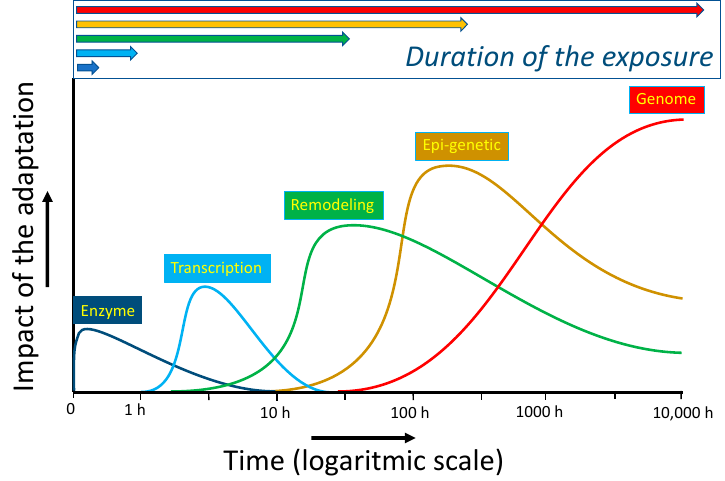
Figure 7. The difference in impact and in the time of onset and duration of several types of adaptations of a cell based on the molecular mechanism of the adaptation. Direct modification of the activity of an enzyme by exposure is an acute adaptive response of cells. In adaptation, due to the activation of the transcription of DNA, there is a lag time in the production of the protective proteins. Remodeling of an organ is a more drastic form of adaptation that takes relatively long and can persist for a relatively long period. Epi-genetic adaptations and especially modifications of the genome can have a large impact, as they can influence the whole population. Adaptation of the level of the genome forms the basis for evolution, which can be seen as an adaptation driven by long-lasting environmental changes, according to the principle of ‘survival of the fittest’. In this paradigm, the genome is, in the end, the ‘information-store’ of the adaption to a persistent change, provided that the organism survives the change. The short time types of adaptation provide the time for the adaptation of the genome to take place. Intriguingly, the genome also stores the information of the other types of adaptation. Adapted from Sthijns et al. [68].